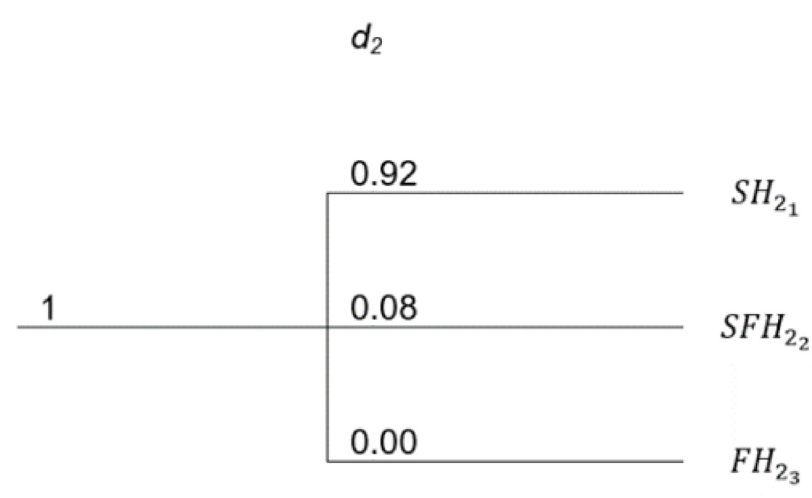
Figure 13. Event tree for activity (Sending the advice note list z 2 .).